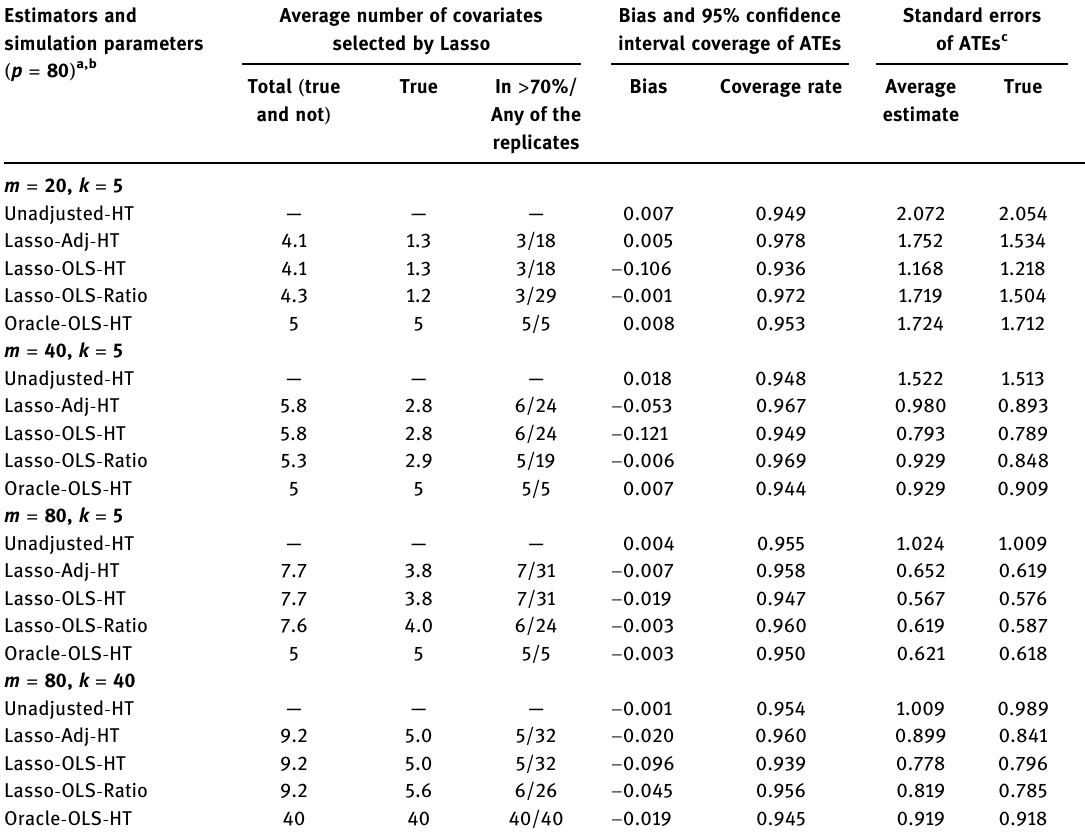
Table 1: Simulation results using the two - stage estimation procedures for ρ = 0 Estimators and simulation parameters ( p = 80 ) a,b